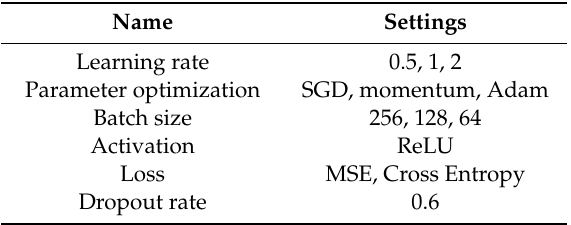
Table 2. Hyper parameter